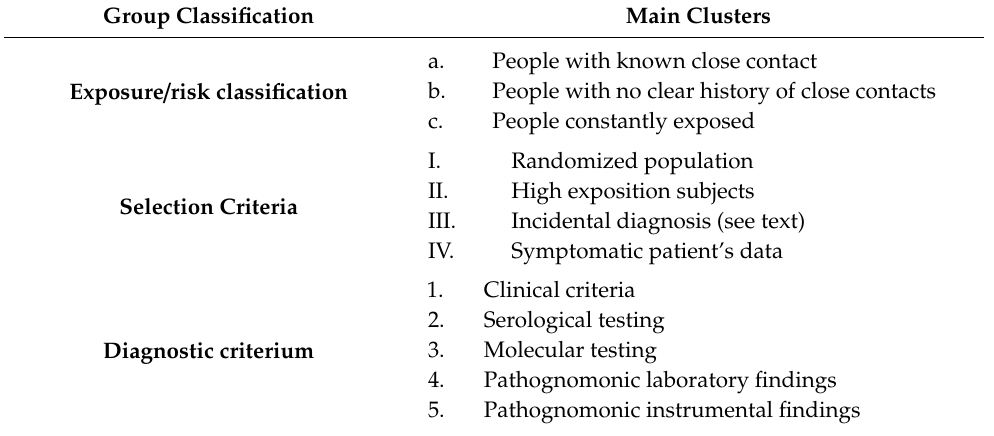
Table 5. The di ff erent classification of the patients enrolled in the study. The di ff erent clusters represent di ff erent clinical and epidemiological scenarios. The information coming from the clinical history of a patient combined with the results of the test and its modification over time will serve to portray a picture of the possible interpretation of the test according to the di ff erent phases, as per Figure 3